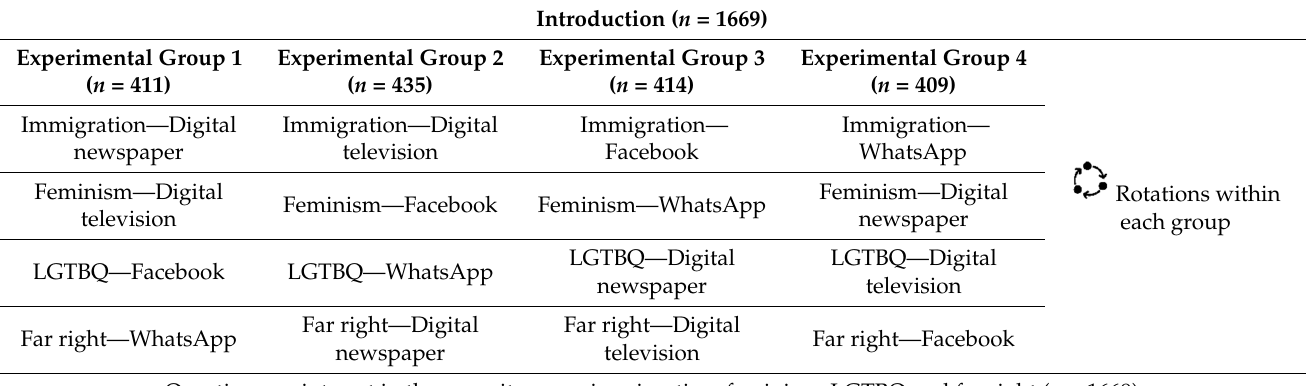
Table 1. Survey administration procedure for each of the experimental groups.